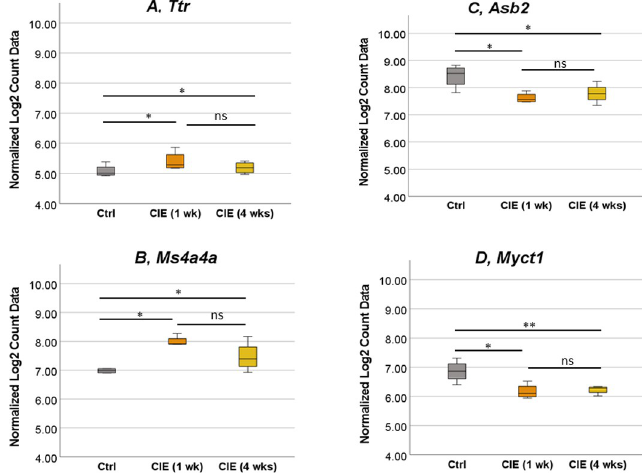
Fig 6. Expression of the genes changed only in the UB of CIE mice. Two genes, Ttr (A) and Ms4a4a (B) were upregulated only in UB samples of CIE 1 wk mice. Additional two genes, Asb2 (C) and Myct1 (D) were downregulated only in UB samples from CIE 1 wk group. The same significant changes were observed for all respective genes in UB samples from CIE 4 wks groups. N = 4 for each group. � p � 0.05, �� p � 0.01. (Fig 6C), and Myct1 (Fig 6D). Ttr gene was upregulated by 2.2-fold in CIE 1 wk group (p < 0.036, Fig 6A), and by 1.7-fold at 4 wks in the UB samples. Ms4a4a had a 2.3-fold increase at 1 wk (p < 0.015, Fig 6B), and 1.6-fold change at 4 wks post-infection (p < 0.011, Fig 6B). In contrast, Asb2 and Myct1 genes were both downregulated in the UB samples at both, 1 wk and 4 wks time points after infection. Asb2 had a -1.8 fold change in CIE 1 wk group (p < 0.036, Fig 6C), and a -1.6-fold change in the CIE 4 wks group (p < 0.013, Fig 6C). Myct1 gene had a -1.7- fold change in the CIE 1 wk group (p < 0.039, Fig 6D), and a -1.6-fold change in the CIE 4 wks group (p < 0.0055, Fig 6D).